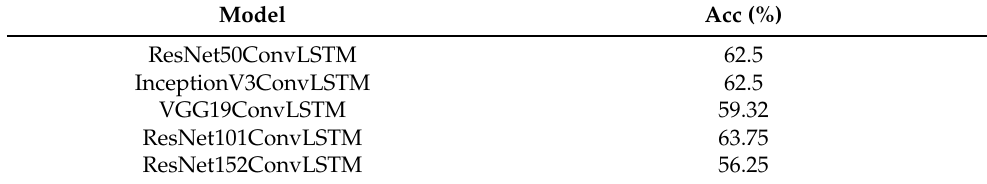
Table 4. Comparison among different type of CNN in keras for binary